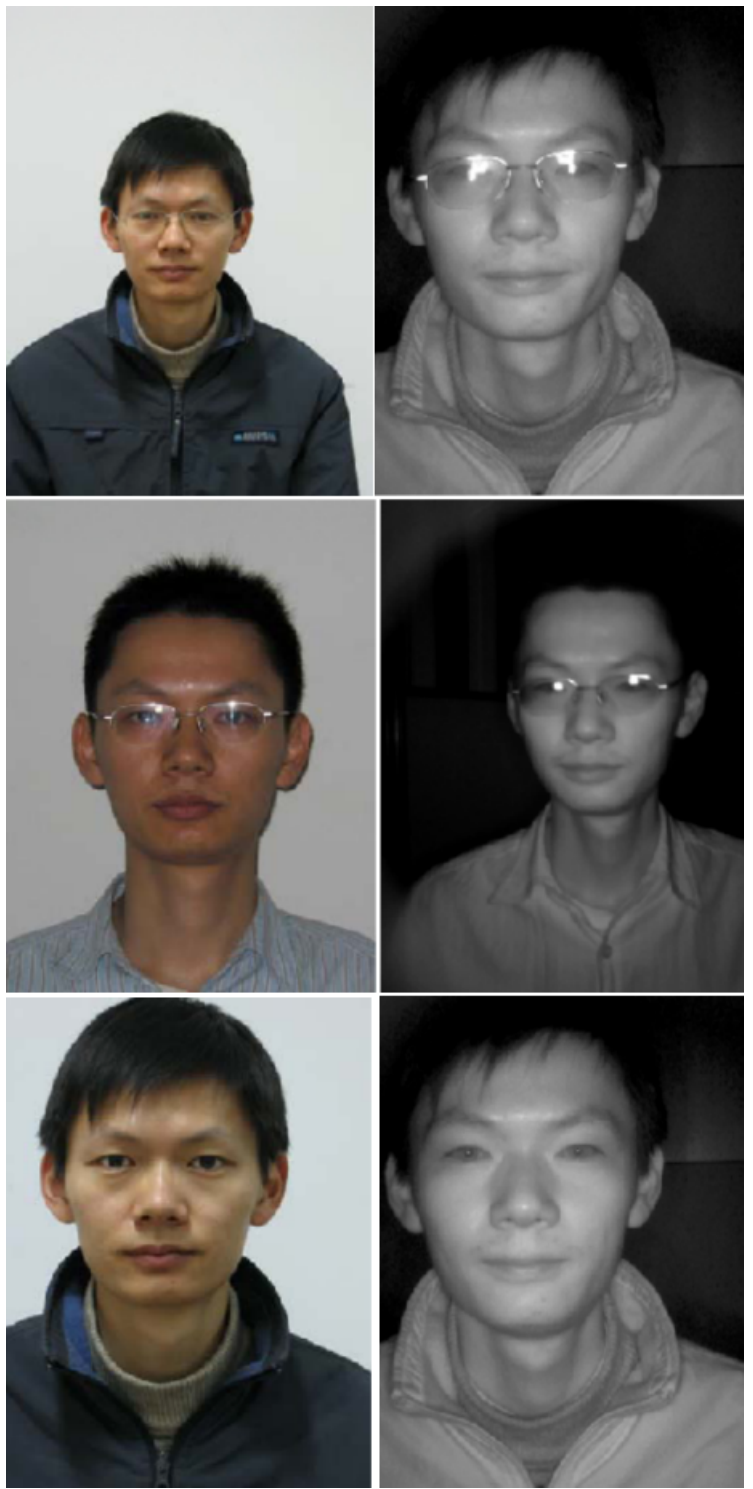
Figure 1. VIS and NIR face images, with variations in resolution, lighting conditions, pose, and age, of one subject in the NIR-VIS2.0 dataset